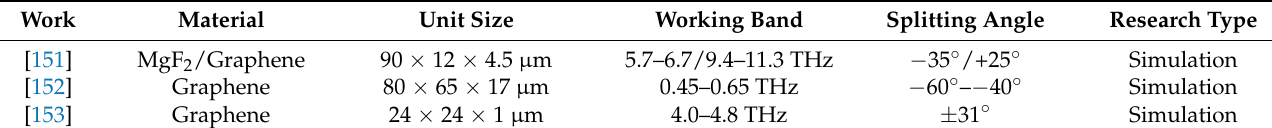
Table 11. Parameters of voltage control tunable metasurface beam splitters described in this section.